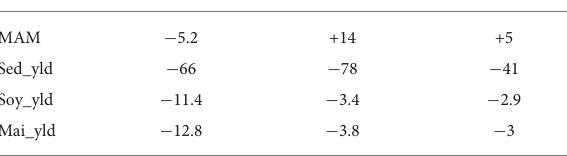
TABLE 1 Summary of performance of all the scenarios under the various